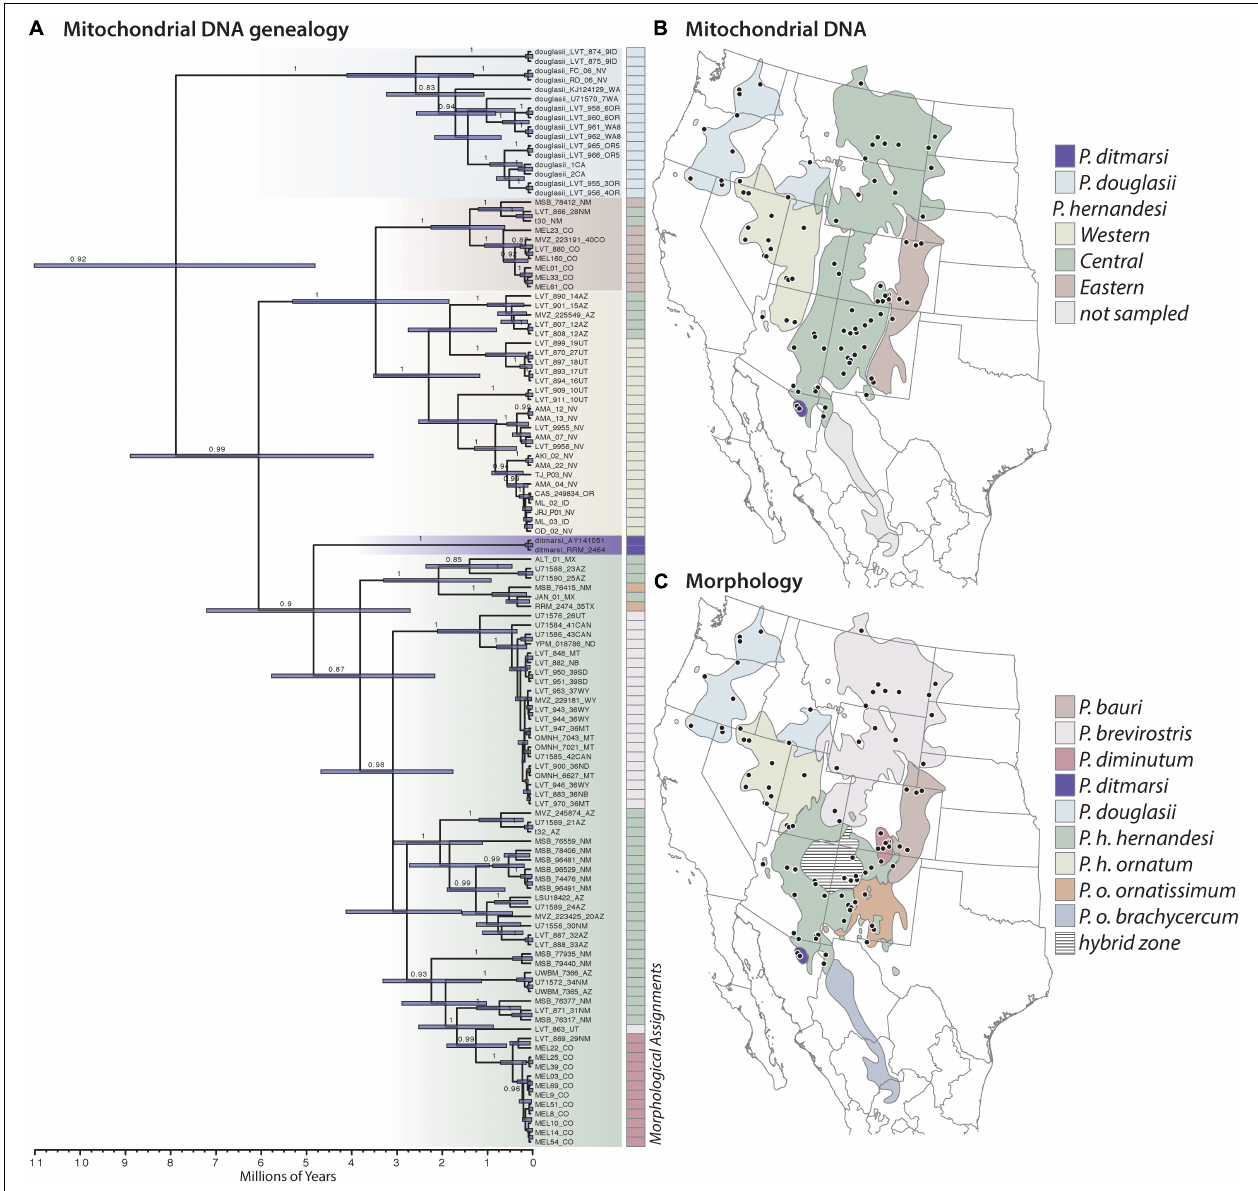
FIGURE 1 | Summary of previous systematic studies of Phrynosoma hernandesi and closely related species belonging to the Tapaja clade, which includes P. ditmarsi, P. douglasii, P. hernandesi, and P. orbiculare (not shown). (A) Mitochondrial DNA genealogy estimated with Bayesian inference (posterior probability values ≥ 80% are shown). The tree was calibrated using a secondary fossil calibration information on the age of Tapaja (12.7 Ma; 95% CI = 10.8–14.7). Node bars show divergence time estimation uncertainty. The genealogy is color-coded to illustrate the species-level taxonomy and phylogeographic groups within P. hernandesi supported by the mtDNA genealogy and described by Zamudio et al. (1997). (B) Geographic distributions of the mtDNA clades within P. hernandesi (modified from Zamudio et al., 1997). Unsampled area of taxonomic importance ( P. o . brachycercum ) is shown in gray. (C) Geographic distributions of species and subspecies based on morphological delimitations (modified from Montanucci, 2015). The hatched area in the Colorado Plateau is one of several putative hybrid zones hypothesized to occur between species. Mapping the morphological taxonomy onto the mtDNA genealogy illustrates their